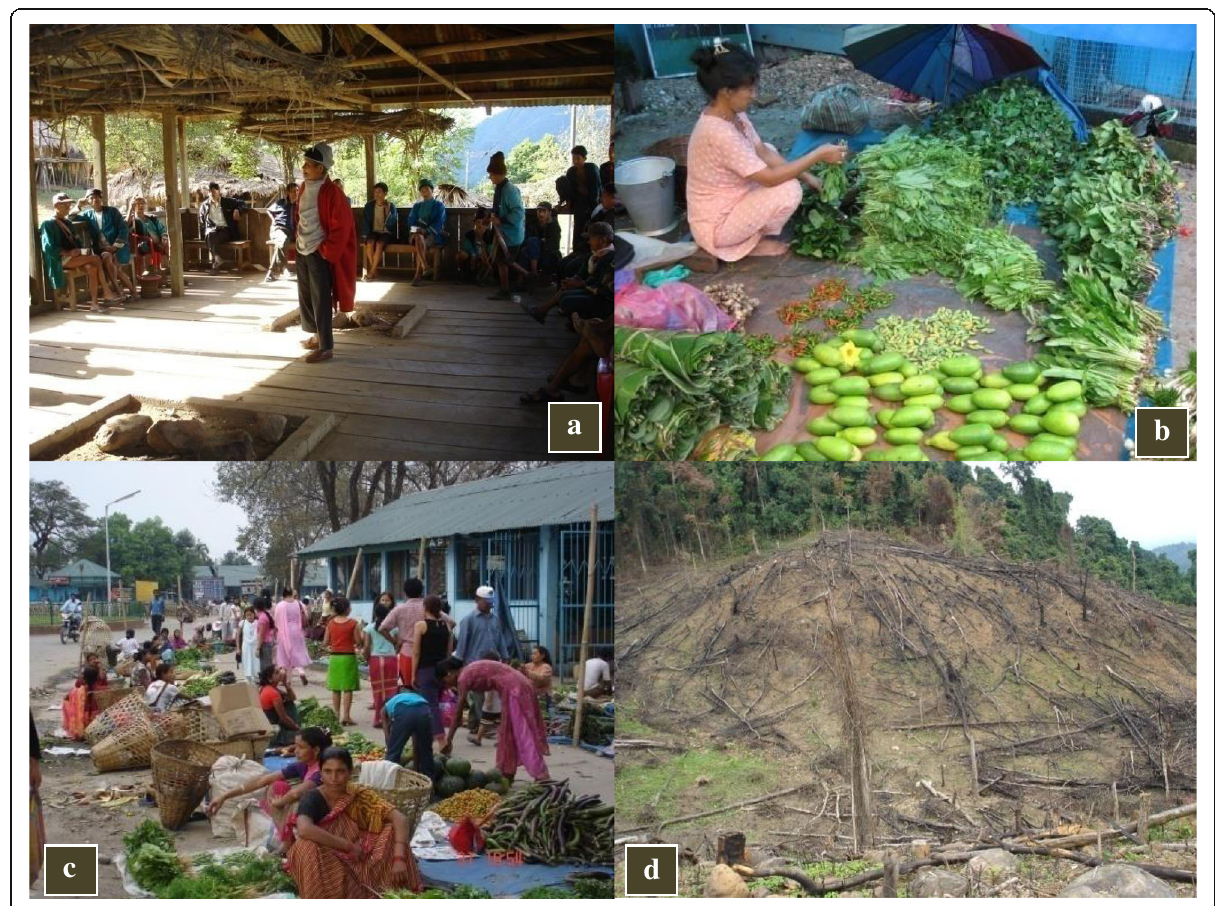
Fig. 2 a A village Kelang going on to solve the dispute over regpi forest between two claimants of same village. b , c Adi women selling indigenous leafy vegetables and other products harvested from regpi forest and home garden. d A regpi forest cleared and burned for establishing an orange